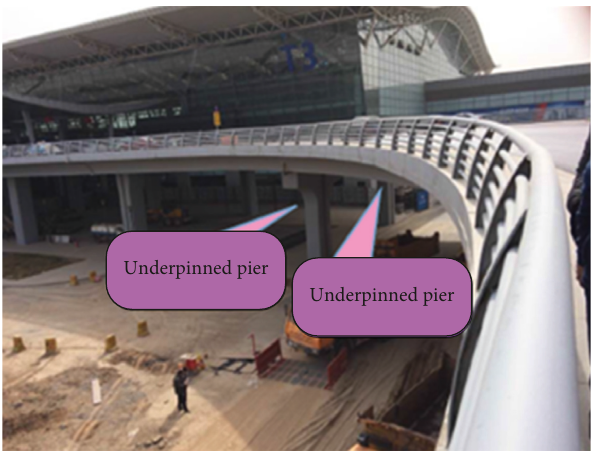
Figure 1: Underpinned